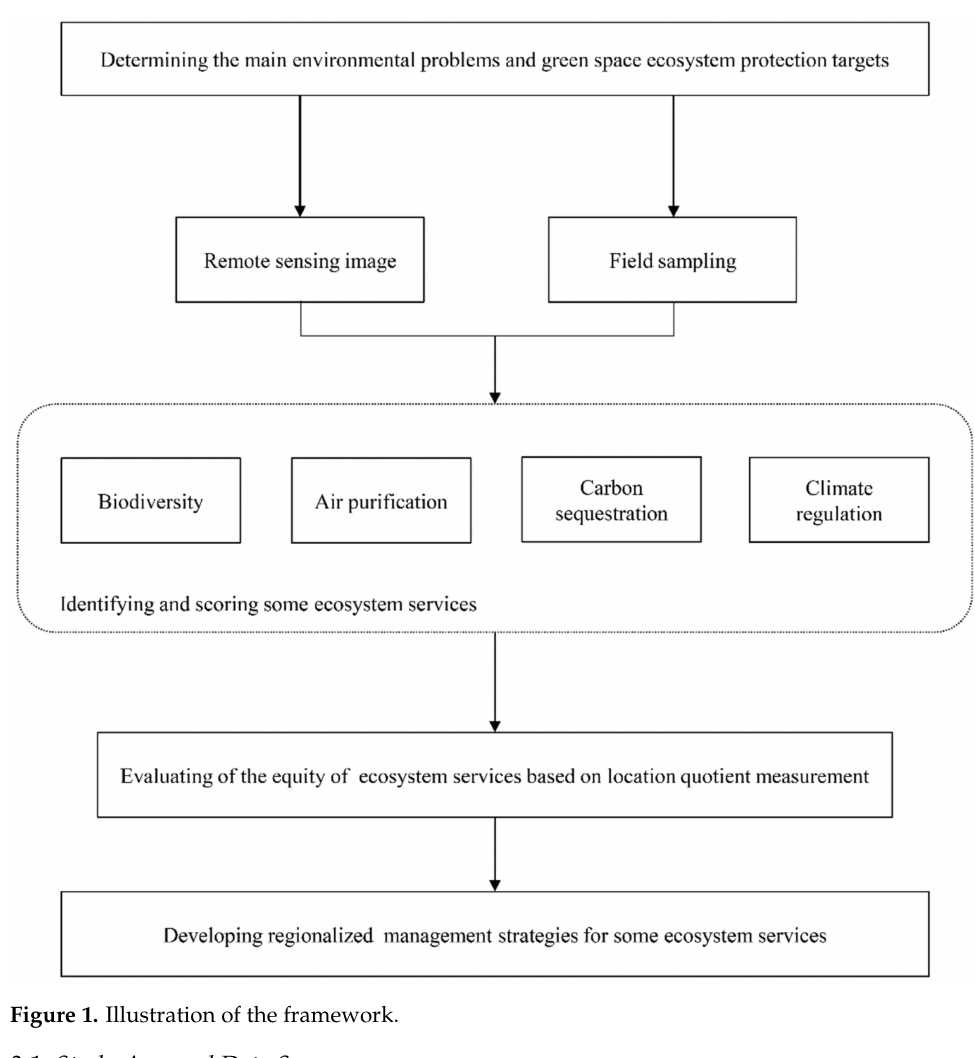
Figure 1. Illustration of the